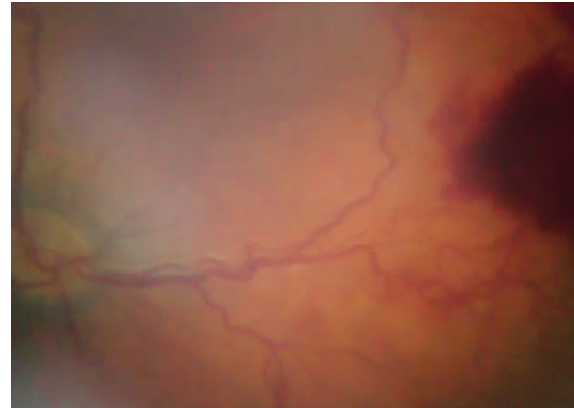
Figure 4: Left eye, right fundus of a 34-week-old postmenstrual age female, with aggressive posterior